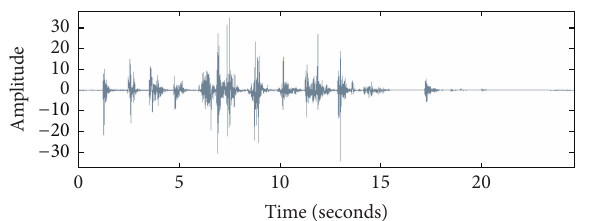
Figure 11: The analyzed real seismic signal with multiple events.